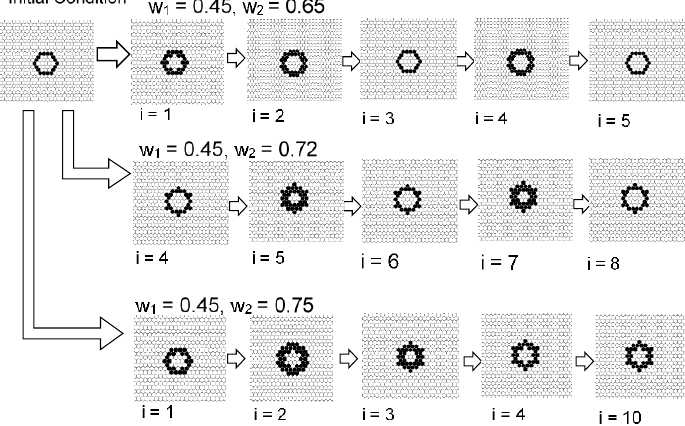
fixed patterns, and results in a pattern close to the Turing pattern.